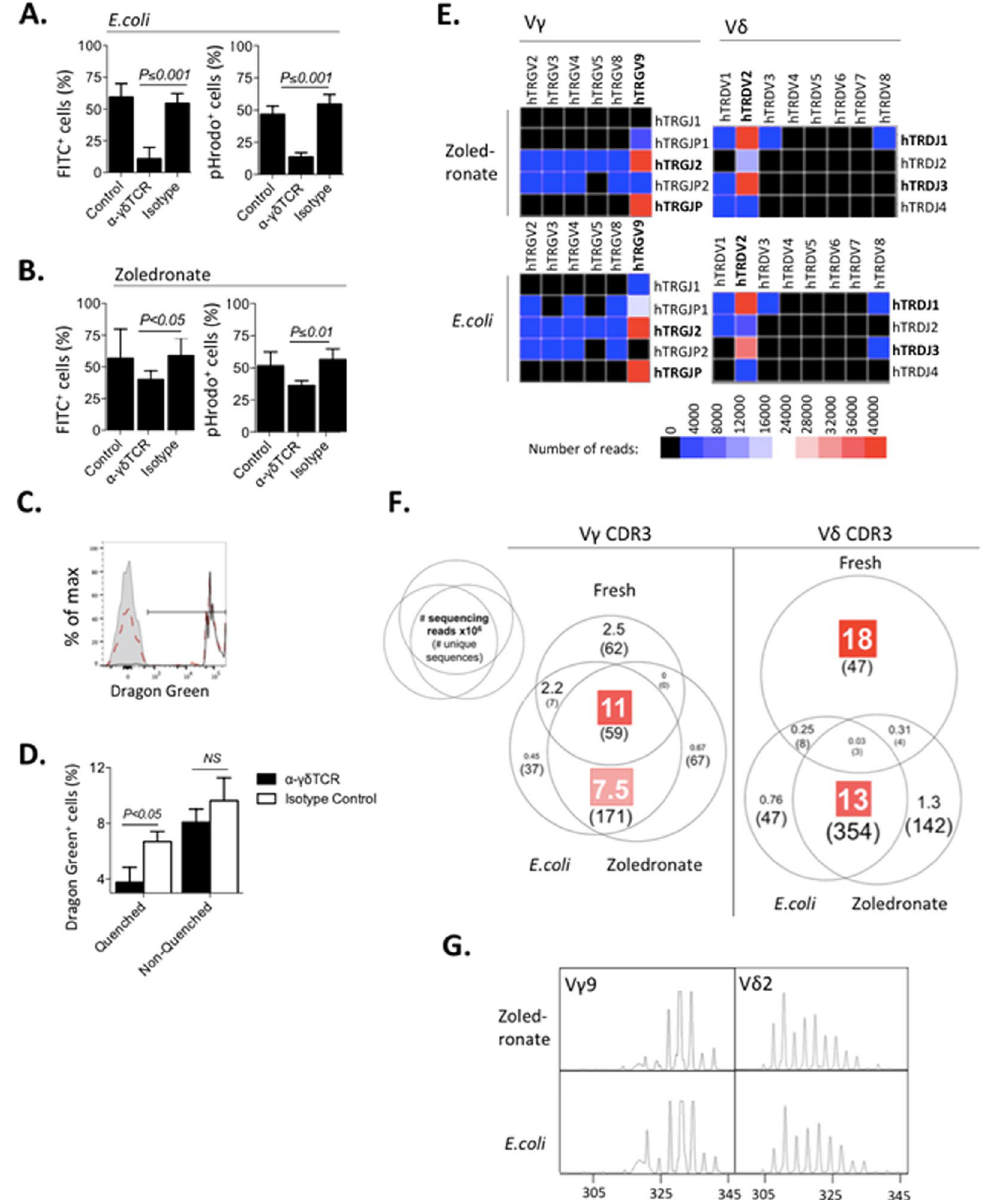
Figure 3. E. coli and Zoledronate-expanded γδ T cells phagocytose E. coli with similar dynamics in a TCR- dependent manner. Freshly-isolated PBMC (n = 5) were expanded with UV-irradiated E. coli or zoledronate for 14 days, and examined for E. coli uptake on day 14. To determine uptake, PBMC were incubated with IgG-opsonized E. coli for 60 min. PBMC were pre-cultured with normal media (control), anti- γδ TCR mAb (clone: B1) or isotype-matched control. The effect of pre-culture with anti- γδ TCR mAb on phagocytosis was examined; data is shown for ( A ) E. coli- expanded or ( B ) zoledronate-expanded γδ T cells, incubated with FITC- E. coli or pHrodo- E. coli . ( C ) PBMC were incubated with opsonized green fluorescent beads and quenched post-culture with Trypan Blue. Shown are representative stains, gated on γδ T cells: i) non-quenched co-culture indicating total bead fluorescence (black, solid, unshaded), ii) quenched co-culture indicating intracellular bead fluorescence (red, dotted, unshaded), iii) cells alone (gray, shaded). ( D ) The effect of anti- γδ TCR mAb was examined on γδ T cell uptake of opsonized bead in quenched and non-quenched samples (n = 3). ( E ) TCR sequencing was carried out on E. coli or zoledronate-expanded and fresh non-expanded γδ T cells. Representative heat maps of one donor E. coli and zoledronate-expanded γδ T cell V γ (VG), V δ (VD) and Vj (VJ) chain reads are shown. ( F ) The number of shared TCR CDR3 sequences was tallied and compared in E. coli or zoledronate-expanded and fresh unexpanded γδ T cells. A comparison of the number of sequencing reads shared as well as the number of unique sequences in each category is shown for both V γ and V δ TCR chains. For all samples, total depth of sequencing was equivalent. Only sequences with more than 5000 reads were tallied to select for the commonest clones. ( G ) TCR CDR3 spectratyping was carried out for E. coli or zoledronate-expanded V γ 9V δ 2 T cells. Representative spectratypes of one donor are